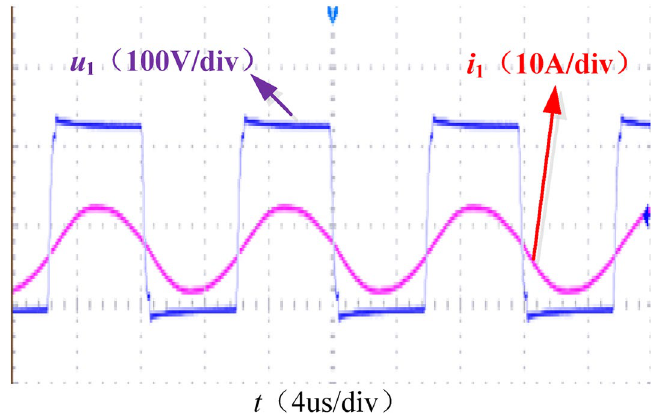
Figure 18. Inverter soft switching